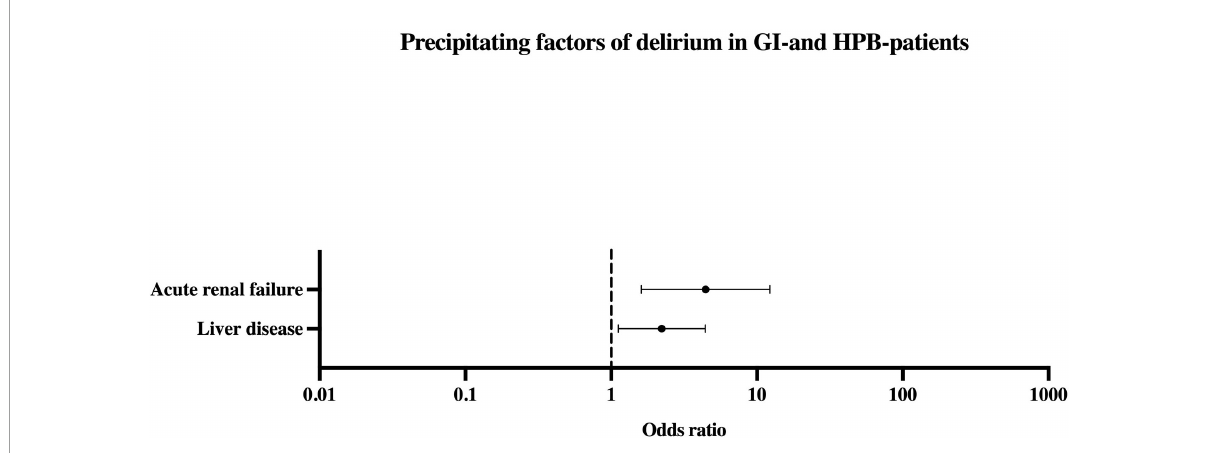
FIGURE4 Precipitating factors of delirium in patients with GI-/HPB-disease. 2 Medical clusters have been identified as precipitating factors (Acute renal failure and Liver disease). Values displayed as Odds ratio. HPB,